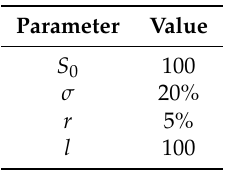
Table 3. Input parameters for pricing π -option on relative